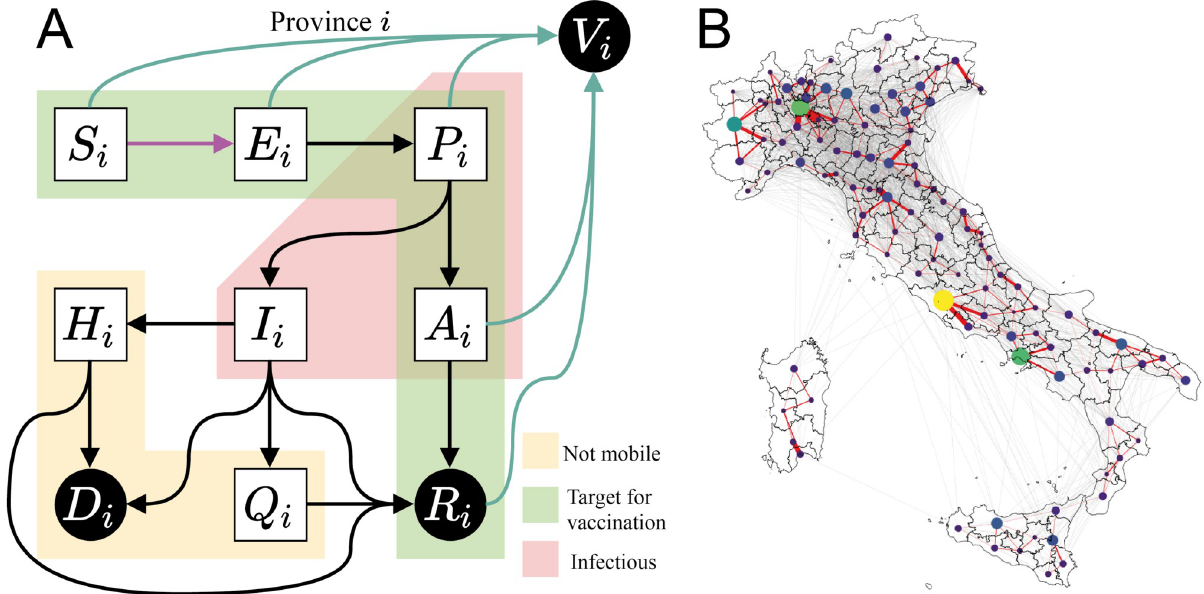
Fig 1. Model setup. (A) Diagram representing the compartments of the epidemiological model and the possible transitions in a single province. We control the vaccination rate (teal arrows), aiming at minimizing incident infections (pink arrow). Individuals in compartments outside of the yellow block are able to move along the mobility network shown in (B), hence the force of infection in a province is coupled with the dynamics of other connected provinces. To reduce the problem to a tractable size, we only consider the most important connections (red edges) when optimizing, but we use the full network (red and grey edges) to assess our strategies. A discussion on the effect of this simplification is provided in section C.2 in S1 Text. Nodes’ size and color display each province’s population, and edges’ width shows the strength of the coupling between a pair of provinces. Base map layer from the Istituto Nazionale di Statistica; Istat, istat.it, CC-BY